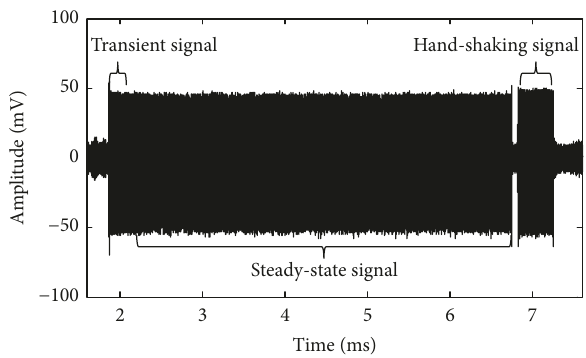
Figure 3: The time domain waveform of radio